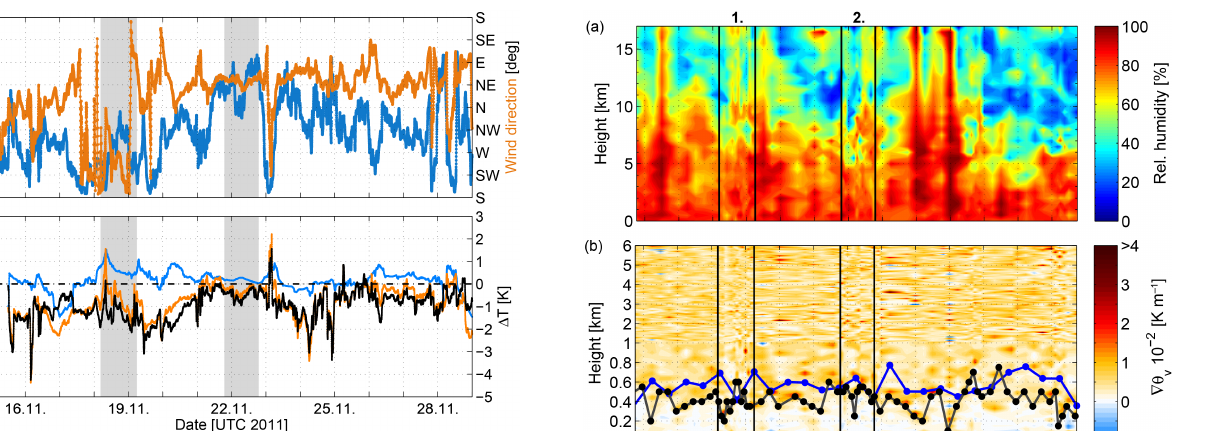
Figure 2. Time series of (a) wind speed (blue) and wind direction (orange) and (b) surface air temperature (SAT, orange) and sea sur- face temperature (SST, blue) on the left scale, as observed on R/V Sonne . The temperature difference of SAT and SST ( (cid:49)T ) is given on the right scale in (b) . The (cid:49)T of 0K is drawn by a dashed line. The shaded areas (grey) in the background show the 24h stations. The data are averaged by a 10min running mean.